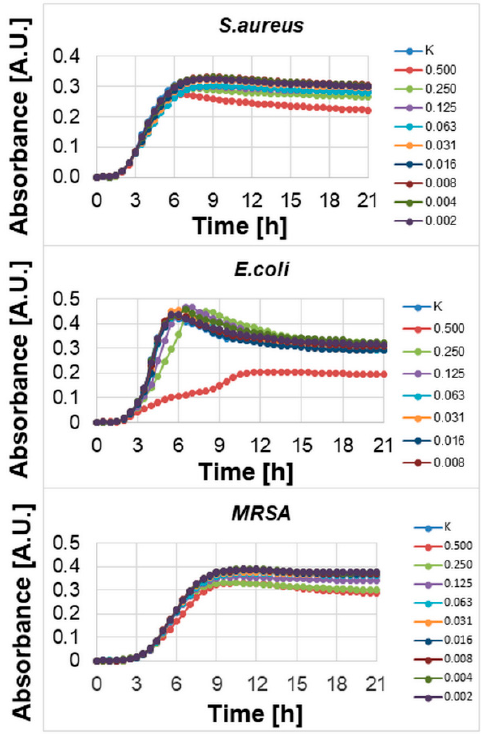
Figure 2. Testing of antimicrobial activity of complex 3 in concentration range 0.002–0.500 mg·mL − 1 after 21 h of treatment on S. aureus , E. coli, and MRSA .